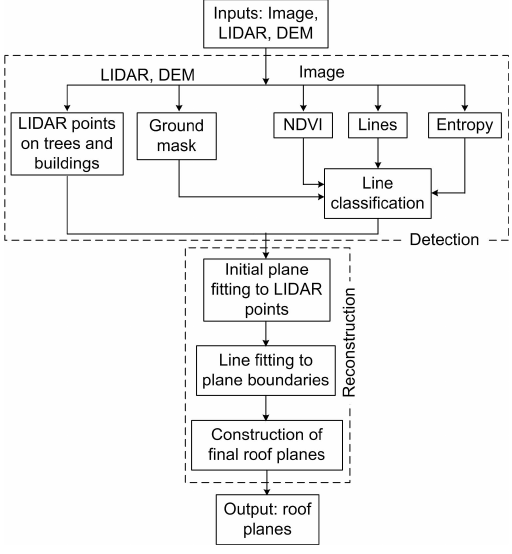
Figure 1: Proposed 3D reconstruction of building